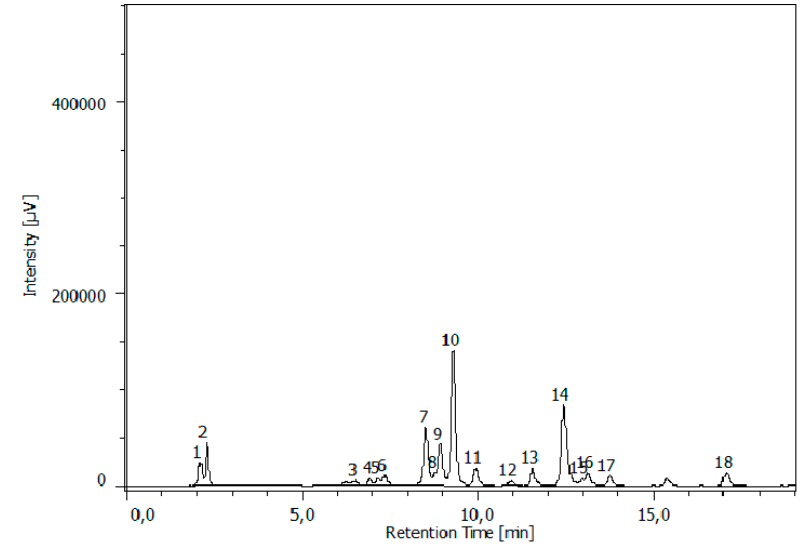
Figure 2. HPLC/FLD chromatograms of GGABA extract at the concentration of 0.5 mg/mL, respectively. The analysis showed the presence of (1) aspartic acid; (2) glutamic acid; (3) serine; (4) glutamine; (5) glycine; (6) threonine; (7) alanine; (8) arginine; (9) GABA 1; (10) theanine; (11) tyrosine; (12) cysteine; (13) valine; (14) GABA 2; (15) phenylalanine; (16) isoleucine; (17) leucine; (18) proline.